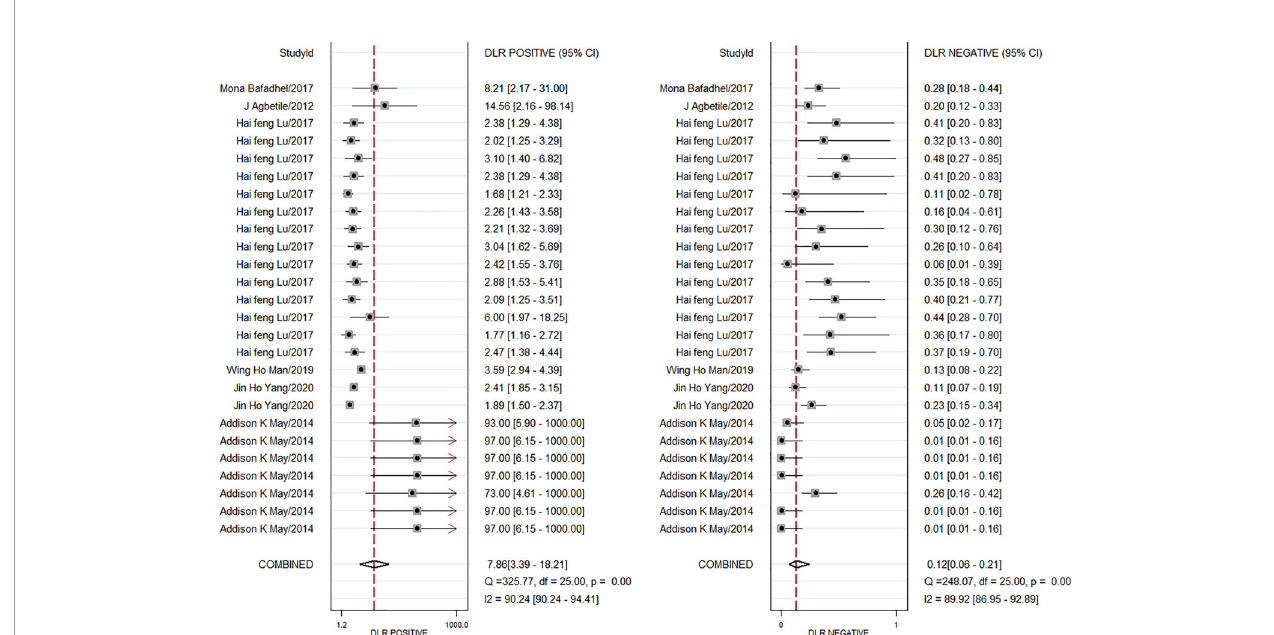
FIGURE 3 | Forest plot of DLR + and DLR − of microbiota biomarkers for the diagnosis of lung